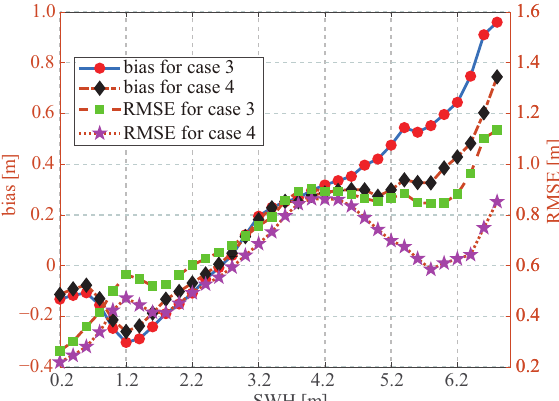
Figure 8. Biases and RMSEs compared between the retrieved SWH and ECMWF data at different SWHs.